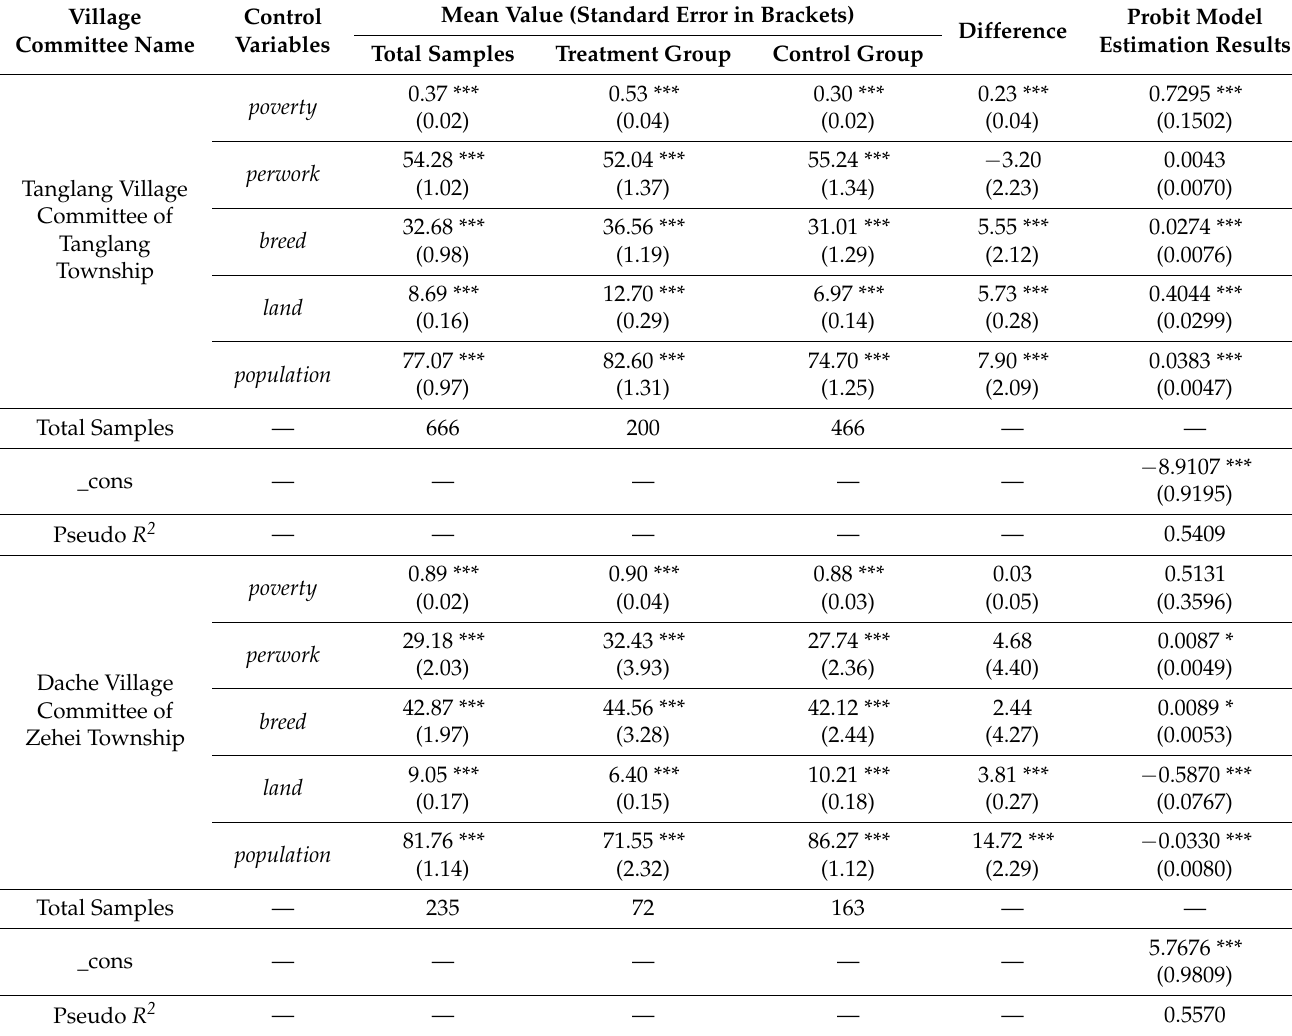
Table 8. Descriptive Statistics of Control Variables and Probit Model Estimation Results in